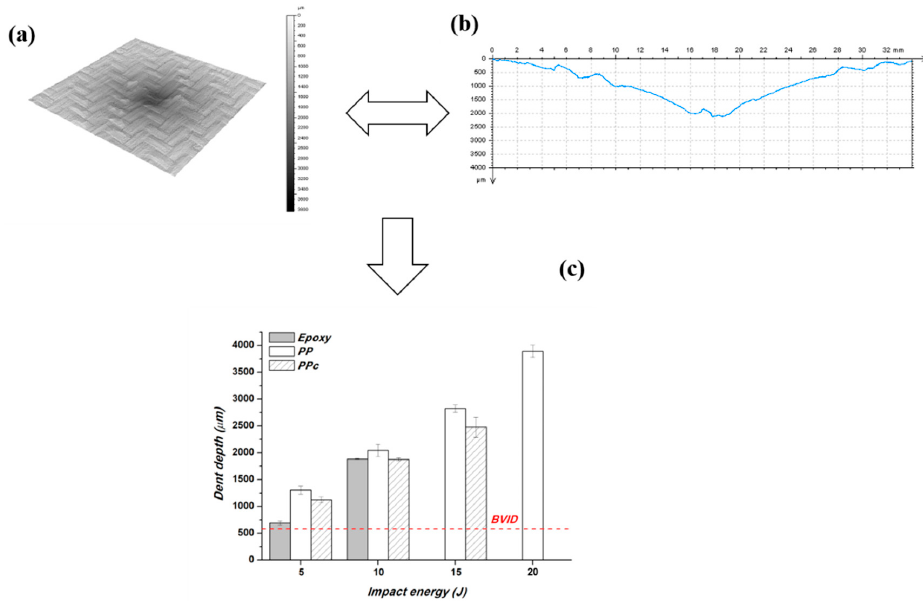
Figure 9. Dent depth: ( a ) 3-D image of damaged specimen; ( b ) extracted profile and ( c ) changes in dent depth on the impacted face of specimens as a function of impact energy and matrix type.